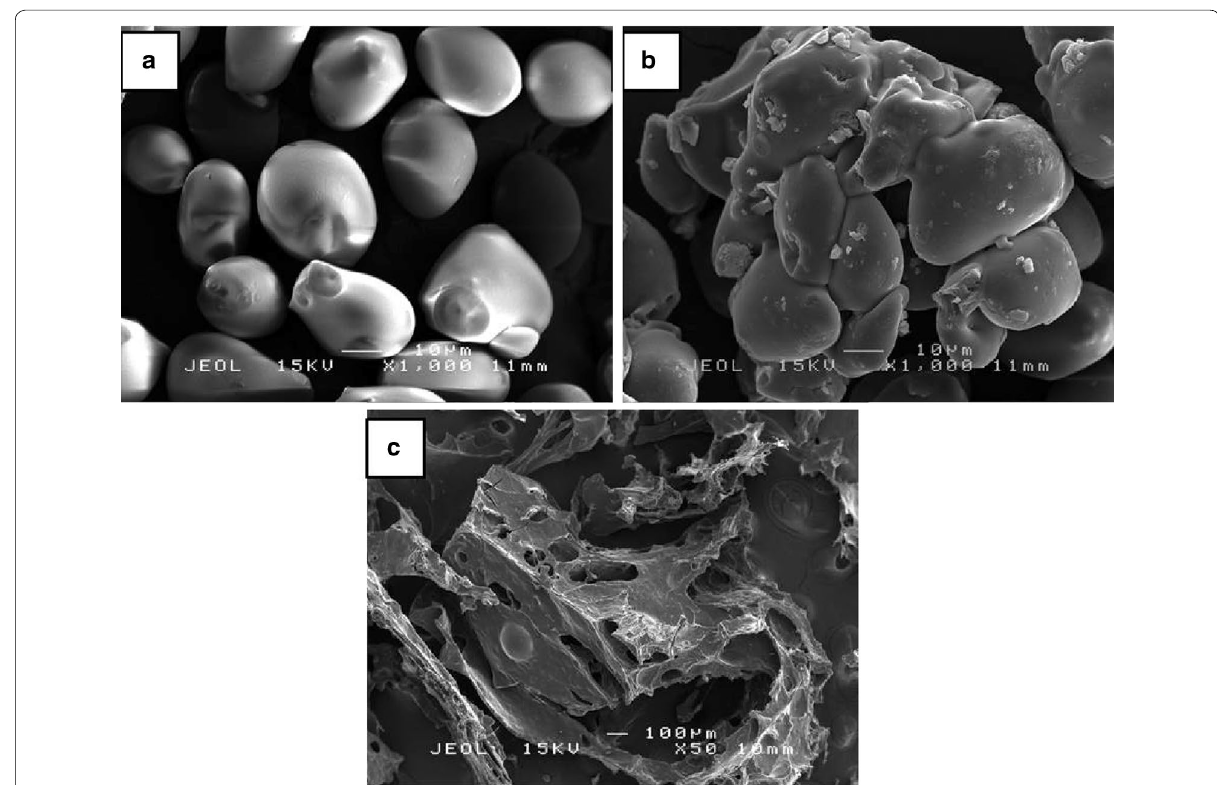
Fig. 10 Scanning electron micrograph of a sago starch, b CMSS and c CMSS–acid